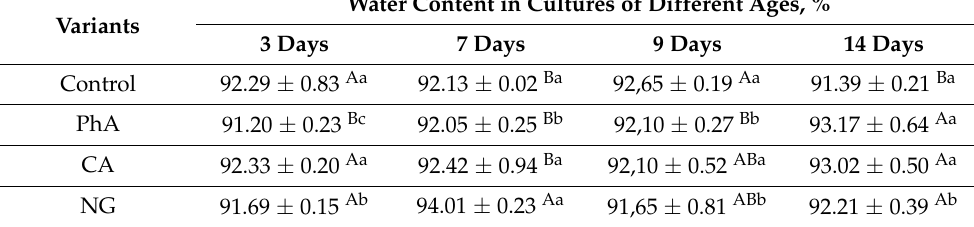
Table 1. Water content in tea callus cultures at different ages grown on the liquid Heller culture medium of the basic composition (Control) or enriched with L -phenylalanine (PhA, 3 mM), trans -